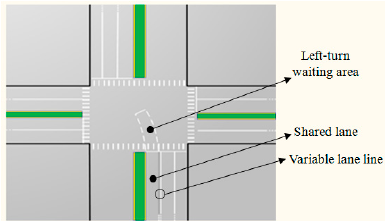
Figure 11. Diagram of left-turn waiting area and variable lane line for the case shown in Figure 10.